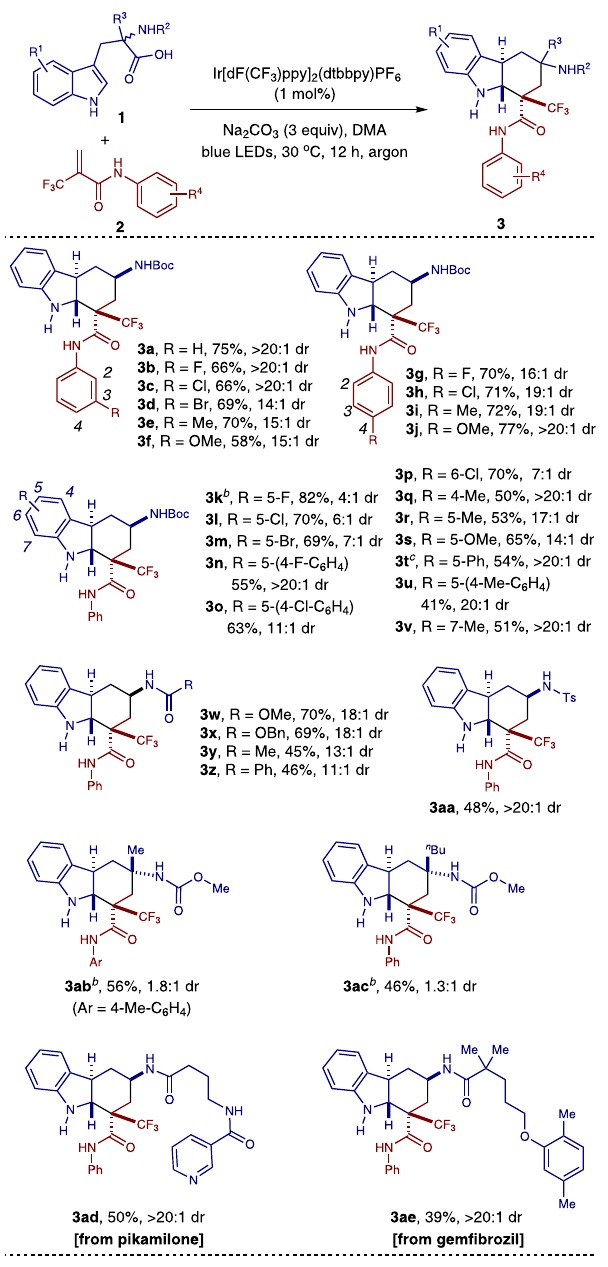
Fig. 2 The substrate scope. a Reaction conditions: 1 mol% of Ir[dF(CF 3 ) ppy] 2 (dtbbpy)PF 6 , 0.3 mmol of Na 2 CO 3 , 0.15 mmol of 1 , 0.1 mmol of 2 in DMA (2.0 mL) for 12 h under blue LEDs irradiation at 30 °C. Isolated yields of major diastereomers are reported. The dr was determined by crude 1 H NMR analysis. b The combined yield of both diastereomers. c The reaction was conducted at 40 °C.